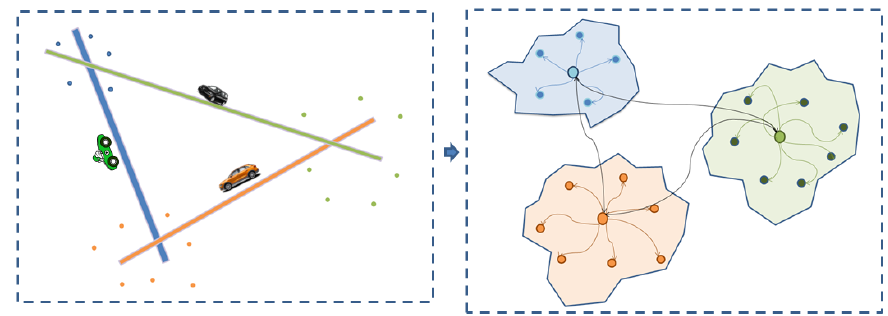
Figure 1. Sample road network mapped into graph